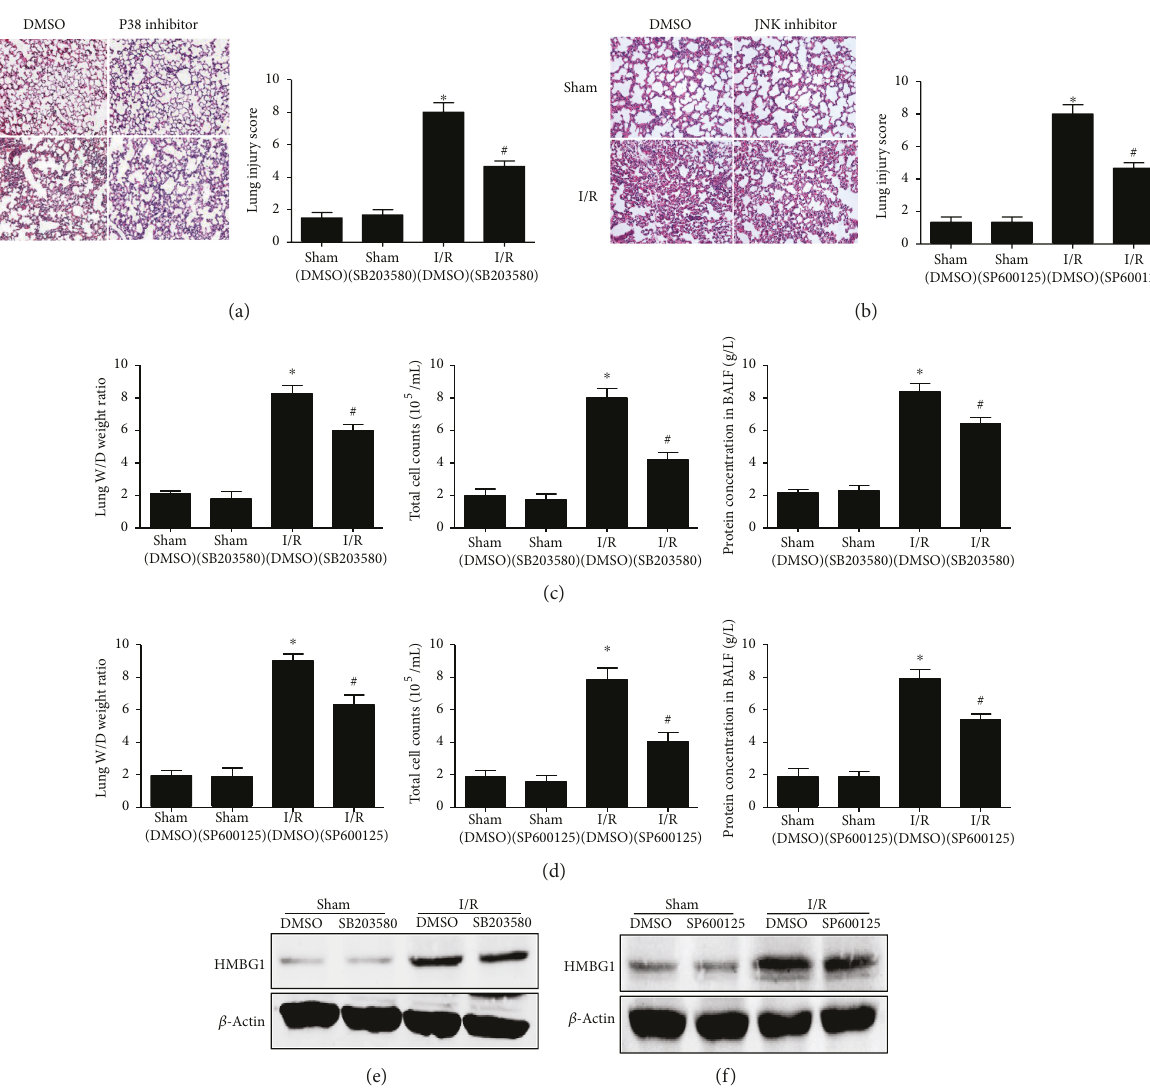
Figure 8: P38 and JNK inhibitors could make little di ff erence on HMGB1 protein level in lung tissue but still relieve the lung injury induced by liver I/R. H&E staining and histological alterations of lung parenchyma were shown (a, b). Degree of lung edema and permeability were re fl ected by W/D ratio, total cell counts, and protein concentration in BALF (c, d). HMGB1 from both inhibitors with or without treatment of lung tissue was also checked (e, f). GraphPad values are presented as mean ± SEM. ∗ P < 0 05 versus the Sham group; # P < 0 05 compared to the liver warm I/R